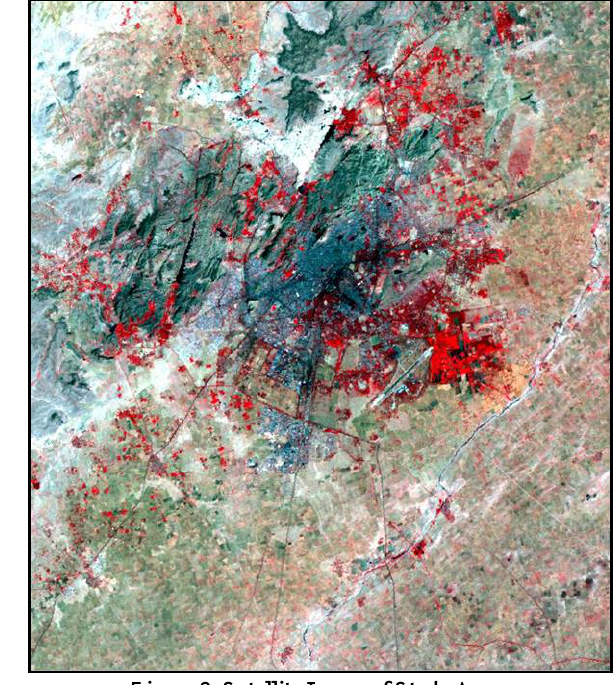
Figure 2. Satellite Image of Study Area (Landsat TM 1990)